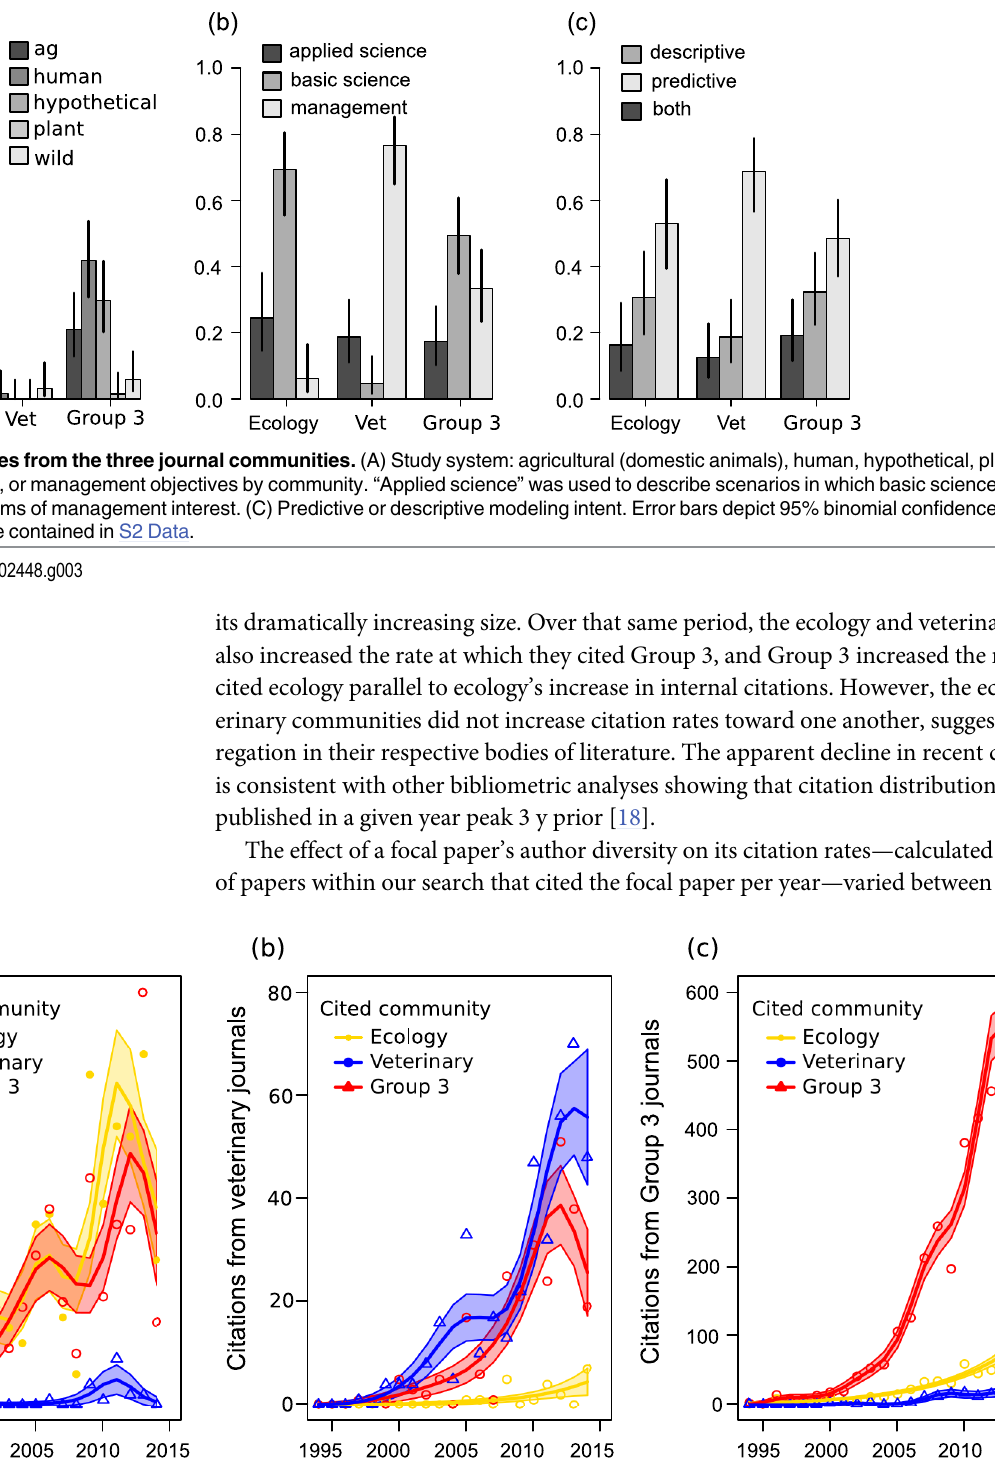
Fig 4. Cross-disciplinary citations through time. (A) Citations from papers in ecology journals to papers in each journal community. (B) Citations from papers in veterinary journals to papers in each journal community. (C) Citations from papers in Group 3 journals to papers in each journal community. Shaded regions are 95% confidence intervals from a Poisson generalized additive model fit to each journal community's time series. Data to generate this figure are contained in S1 Data.